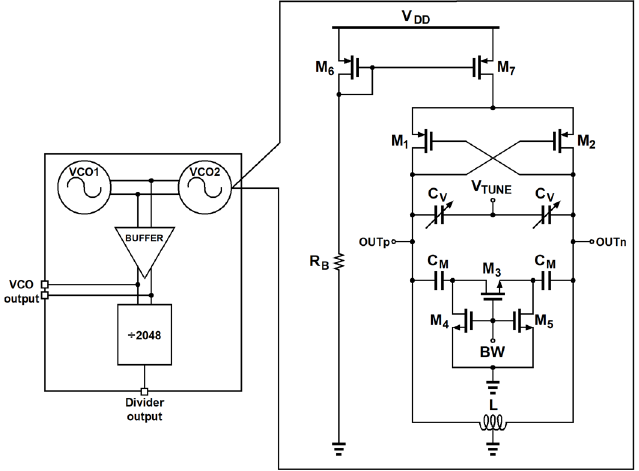
Figure 2. Simplified block diagram and voltage-controlled oscillator (VCO) schematic. The tank inductor was fabricated using a two-layer structure (i.e., a top thick copper layer + Alucap). A patterned ground shield (PGS), made with the first thin copper layer, was used to guarantee a proper ground model in the simulation. An optimized inductor width of 11 um was chosen for obtaining the best tradeoff between quality factor (QL) and self-resonance frequency (SRF). Electromagnetic (EM) field solver (i.e., Keysight ADS Momentum) has been widely used to extract S-parameters of inductor and interconnections between the inductor itself and all the other VCO elements (i.e., cross-coupled active pairs, varactor, switched-capacitor bank, and ground plane). A 3D view of the inductor together with simulated inductance values and quality factors are shown in Figure 3a,b, respectively.